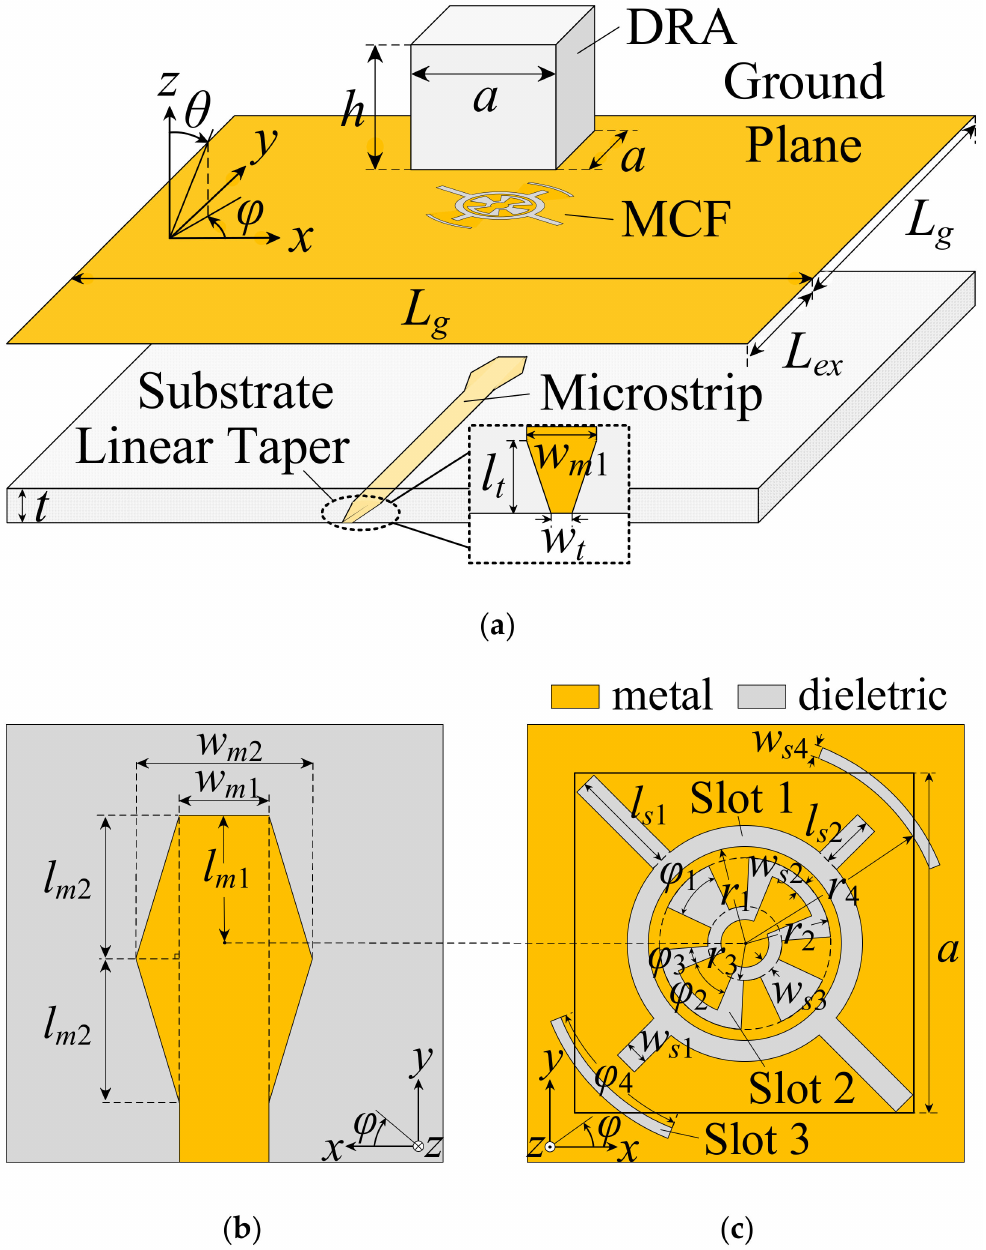
Figure 1. The geometry of proposed dual-bands CP RDRA: ( a ) Perspective view of the entire structure; ( b ) Bottom view of the end of the microstrip line; ( c ) Top view of the MCF